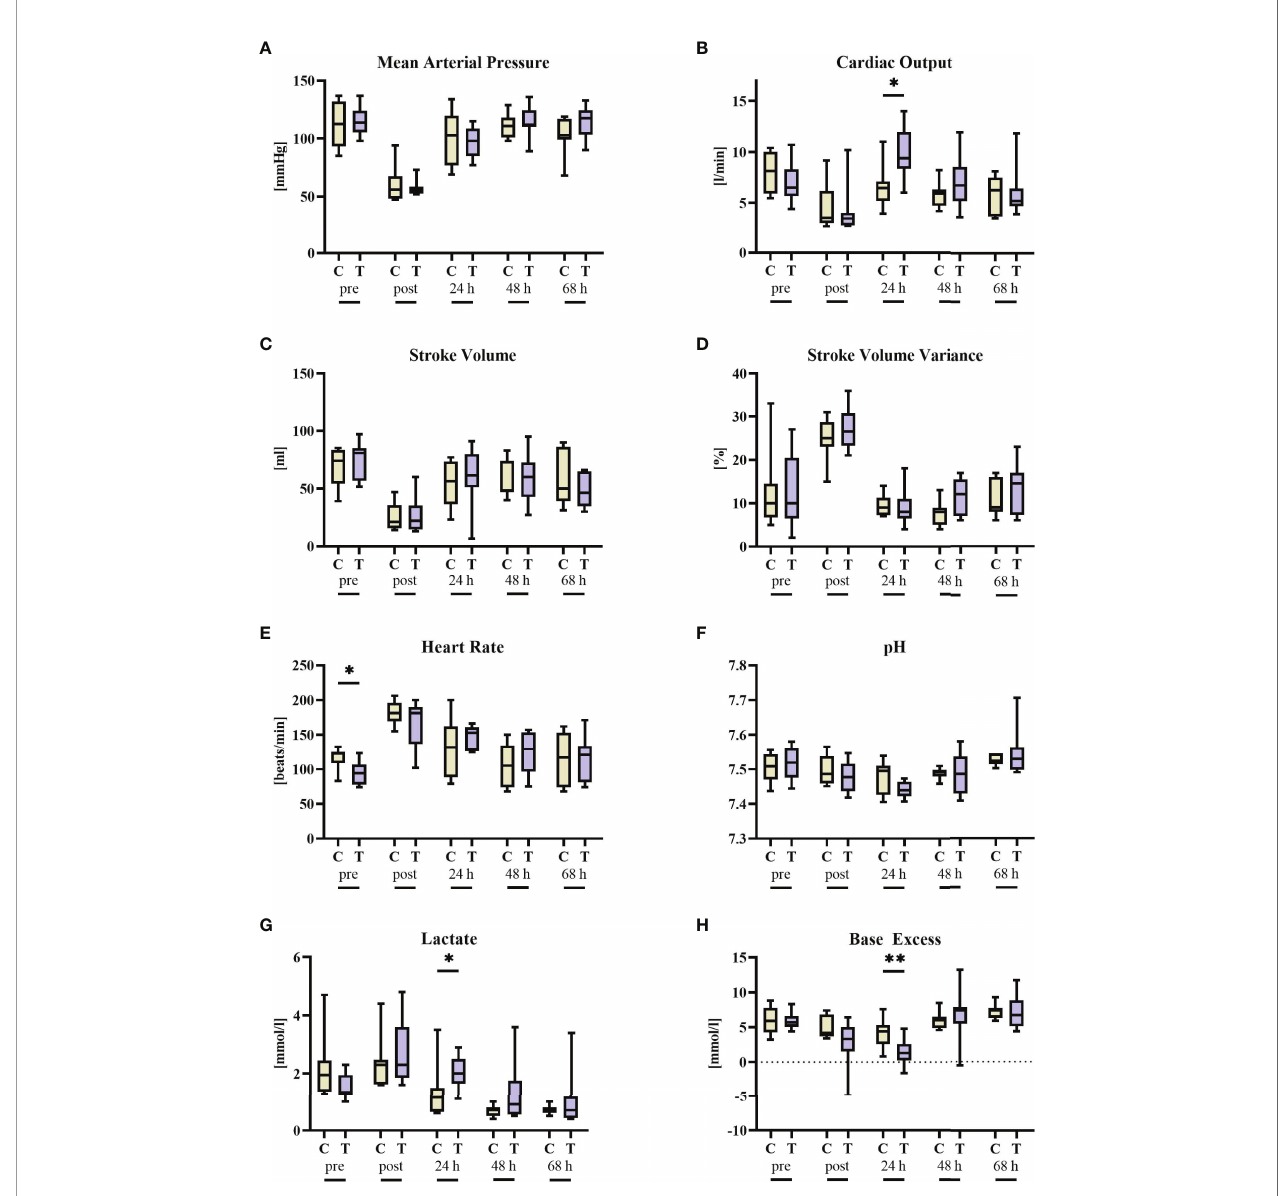
FIGURE 2 | Cardiocirculatory parameters before (pre) and after 3 h of hemorrhagic shock (post) as well as 24 h, 48 h, and 68 h after resuscitation. (A) mean arterial pressure, (B) cardiac output, (C) stroke volume, (D) stroke volume variance, (E) heart rate, (F) blood pH, (G) blood lactate, and (H) blood base excess. n = 8/9 before shock, 8/9 after shock, 8/9 at 24 h, 7/9 at 48 h, and 7/8 at 68 h animals per group for vehicle control (yellow, C) and thiosulfate (purple, T), respectively. * = p < 0.05, ** = p < 0.01, Mann-Whitney U test. Box plots report median, interquartile range, minimum, and